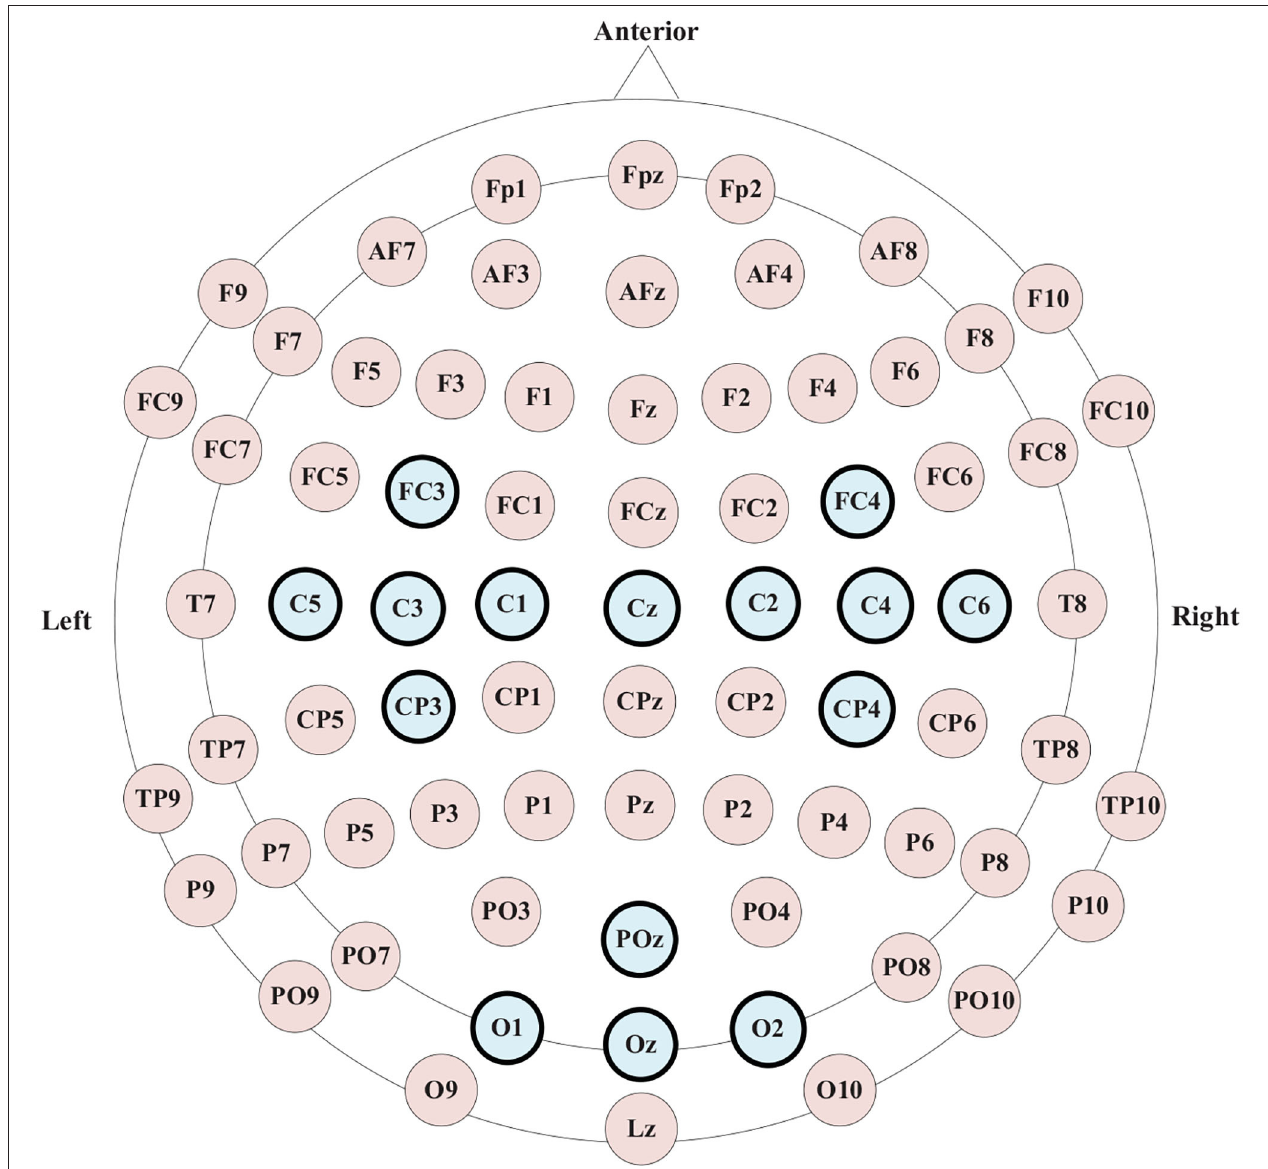
FIGURE 1 | Names and distribution of EEG